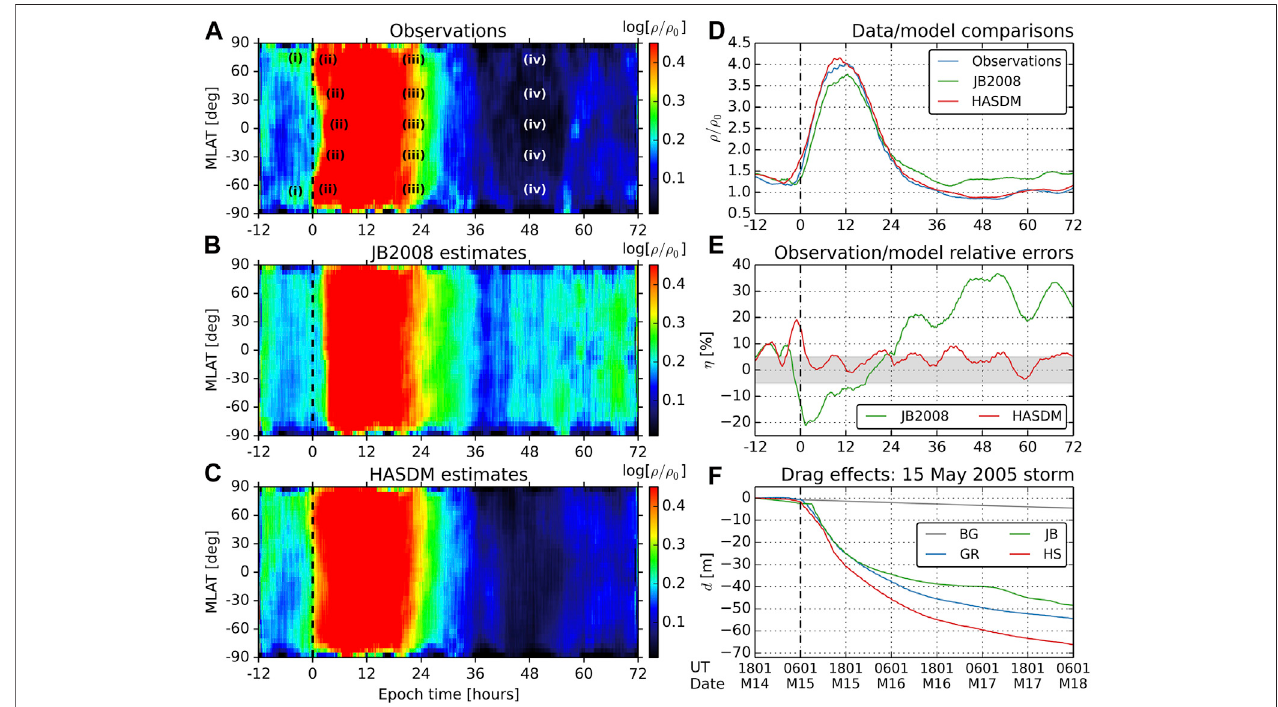
FIGURE 2 | Left column: superposed epoch analysis results of thermospheric neutral mass density response using the methodology introduced by Oliveira et al. (2017) with observations (A) , JB2008 estimates (B) , and HASDM estimates (C) . Right column: density averaged within – 50 ° ≤ MLAT ≤ 50 ° in a 15-min cadence (D) ; densityestimateerrorswithrespecttoobservationscomputedas η i (cid:2) ( ρ i - ρ obs )/ ρ obs ,with i (cid:2) (JB2008,HASDM) (E) ;storm-timedrageffectscomputedforGRACE ’ sorbit during the May 15, 2005 extreme storm using the framework provided by Oliveira and Zesta (2019) (F)